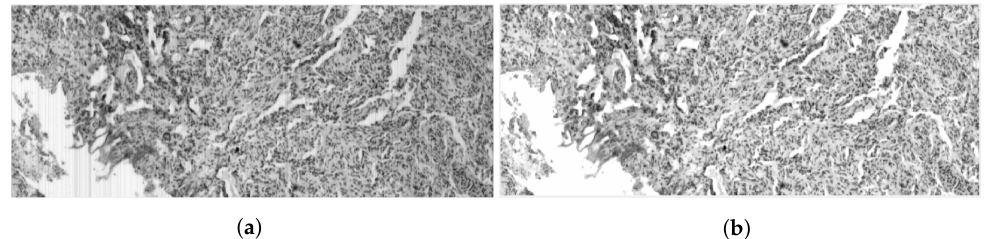
Figure 5. Raw image ( a ) and calibrated image ( b ) for a brain tissue histology sample at band number 302 (619 nm).